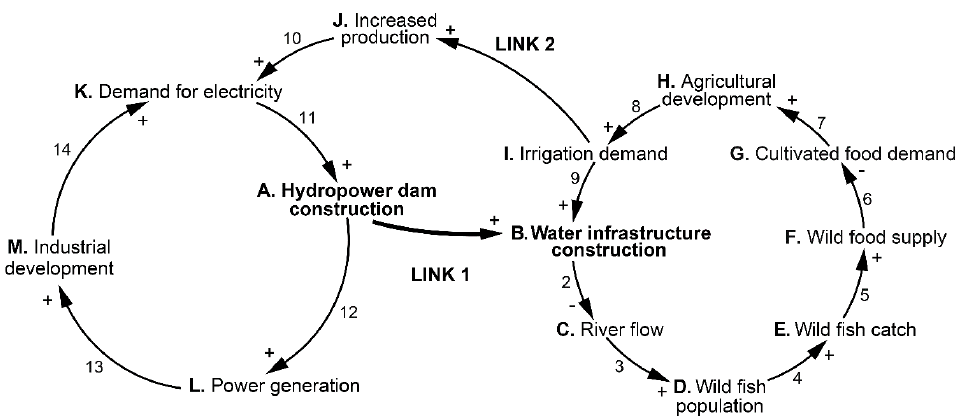
Figure 7. Influence model for the hydropower–food supply nexus in the lower Mekong Basin.